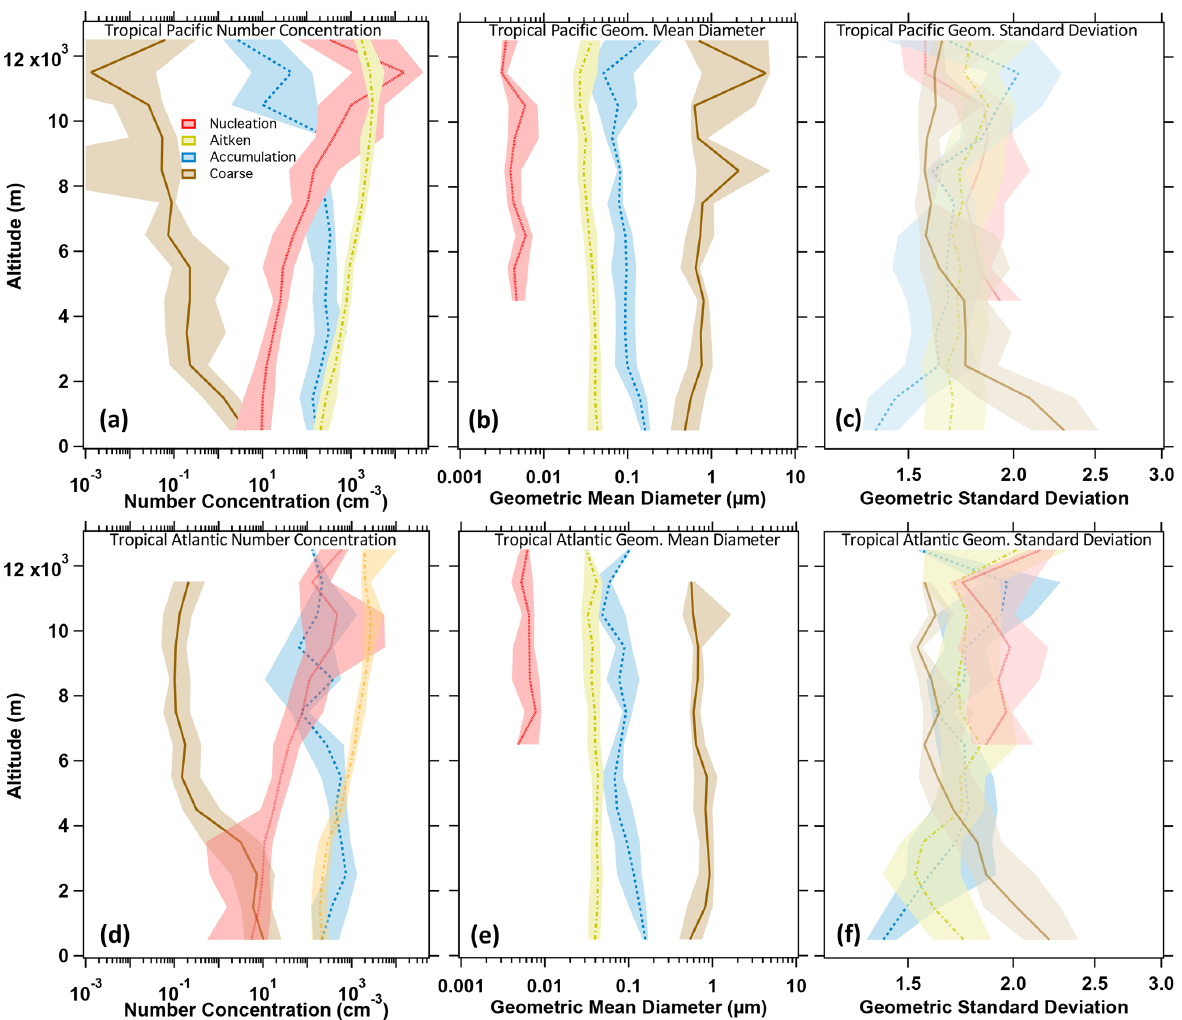
Figure 12. Vertical profiles of fitted lognormal parameters for the nucleation, Aitken, accumulation, and coarse modes for the Pacific trop- ics (a, b, c) and the Atlantic tropics (d, e, f) for the entire ATom project. Lines are median values, and shaded regions show the interquartile range. Number concentrations for the nucleation mode extend to lower altitudes than the geometric mean diameter and standard deviation because samples with very low or zero concentrations could not be fitted, yet they still provide valid concentration data that should be av- eraged. Similar vertical profiles for other regions sampled during ATom are in Figs. S1–S2. The number of 60s samples contributing to the values in each altitude bin is provided in Fig.